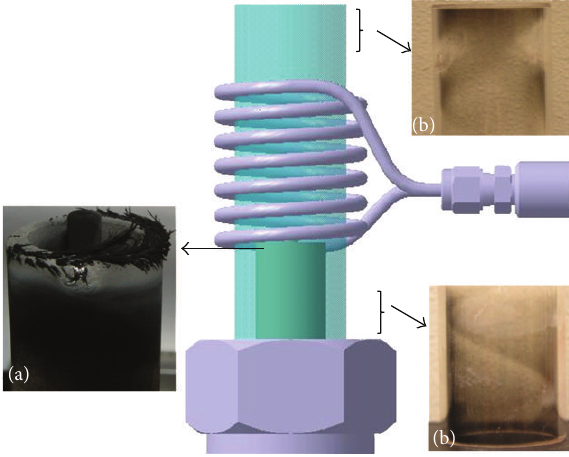
Figure 4: Powders location on the ceramic protection (a) and on quartz tube